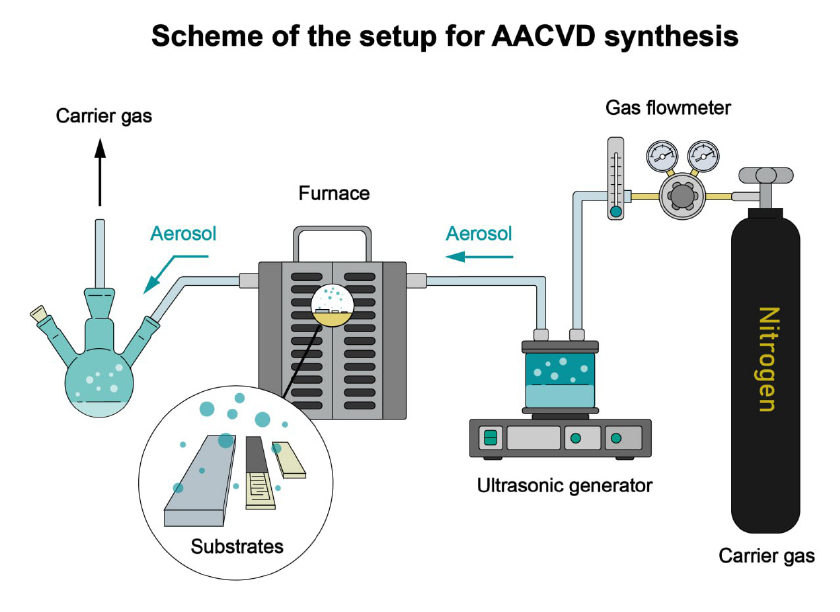
Figure 1. Scheme of the setup for AACVD synthesis of ZnO/Fe 2 O 3 thin